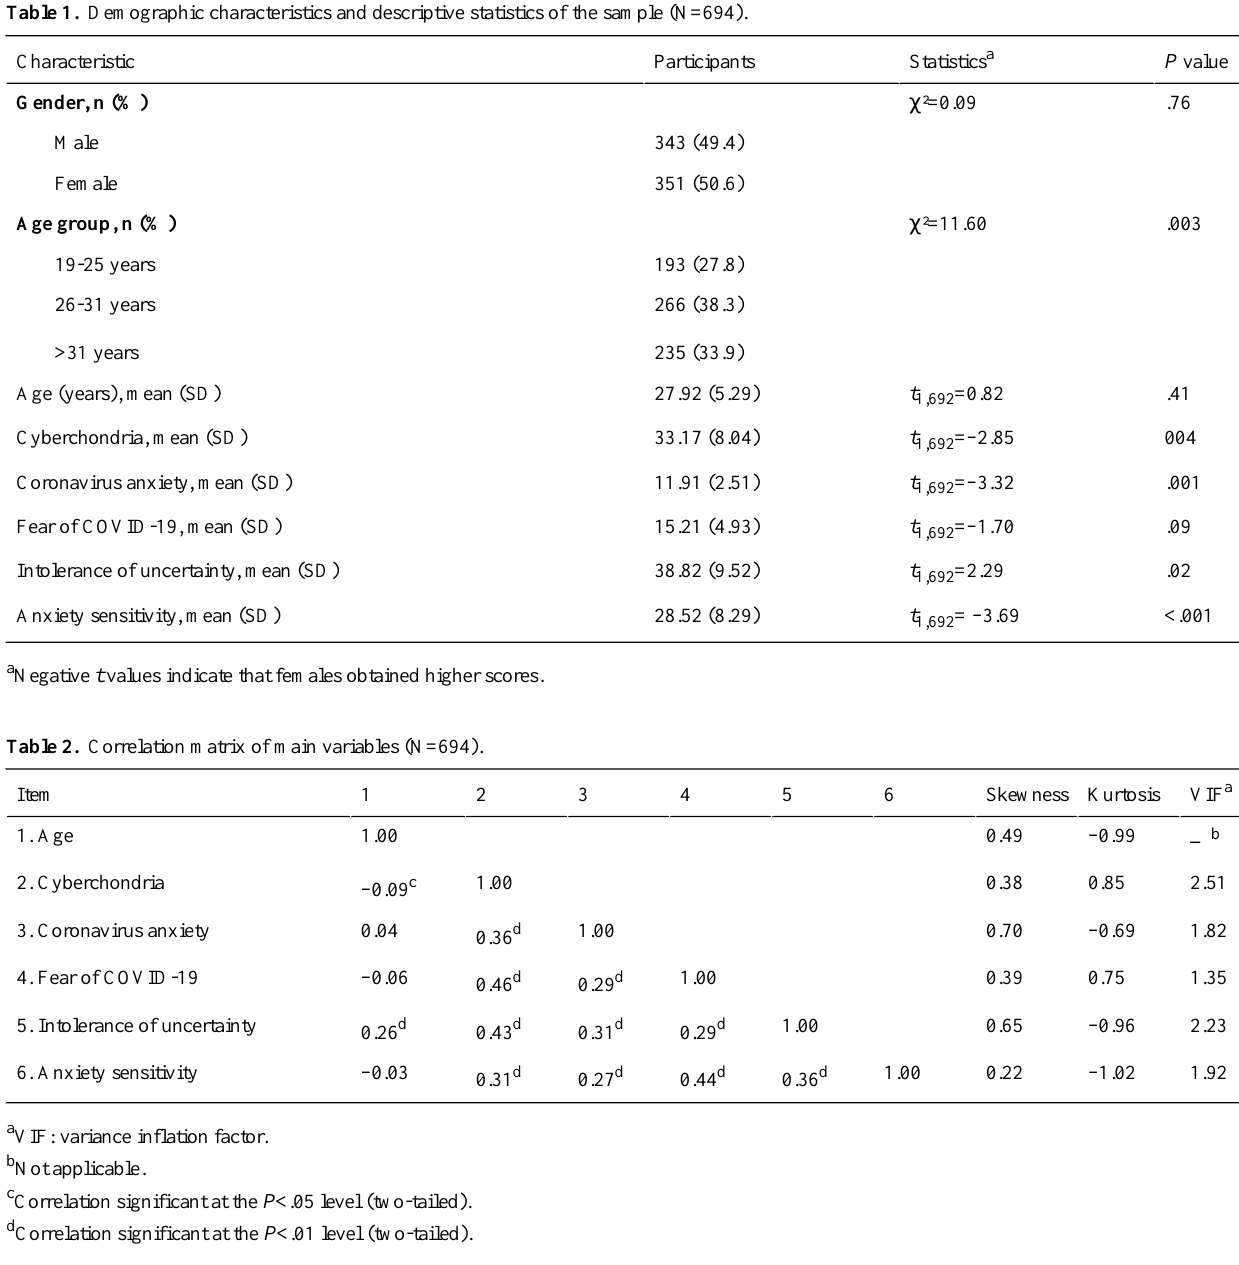
Table 1. Demographic characteristics and descriptive statistics of the sample (N=694).